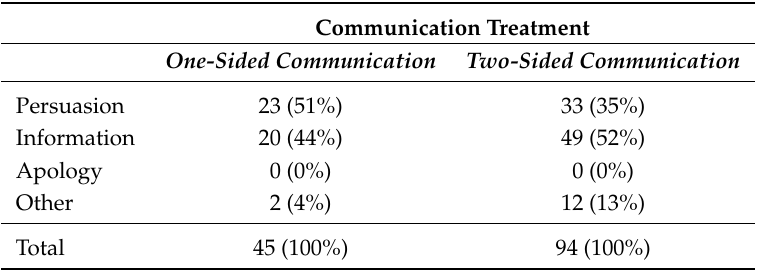
Table 5. Rater 1’s